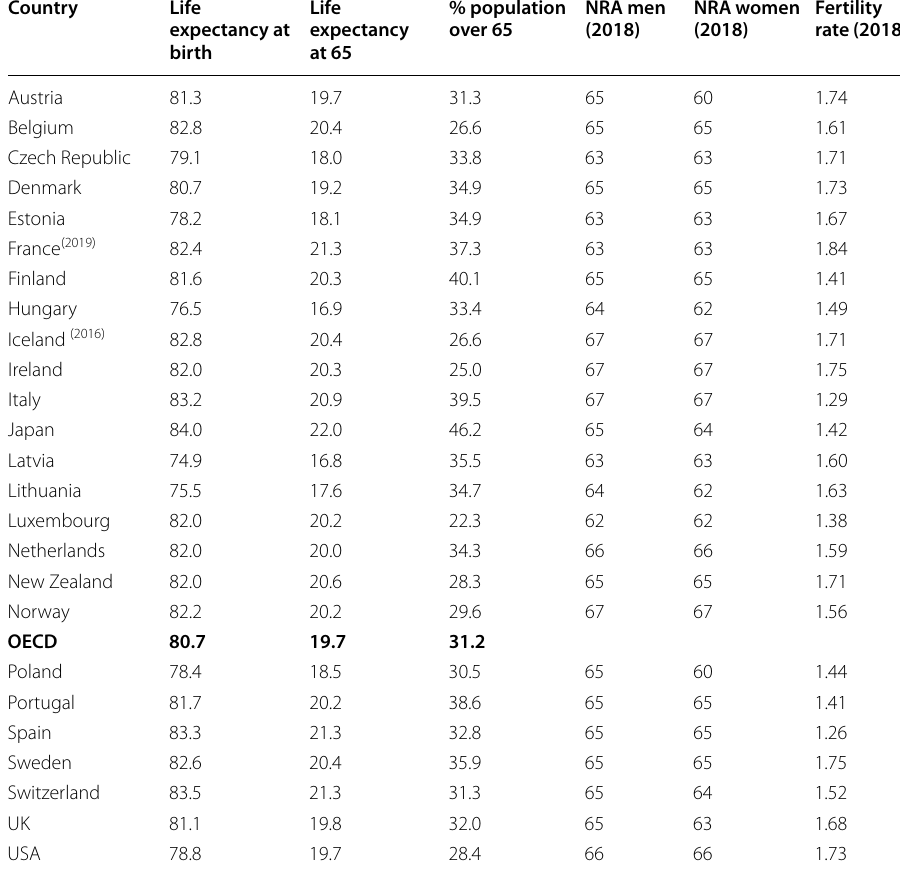
Table 2 Summary indicators of longevity and NRA for selected countries (listed in alphabetical order) Country Life expectancy